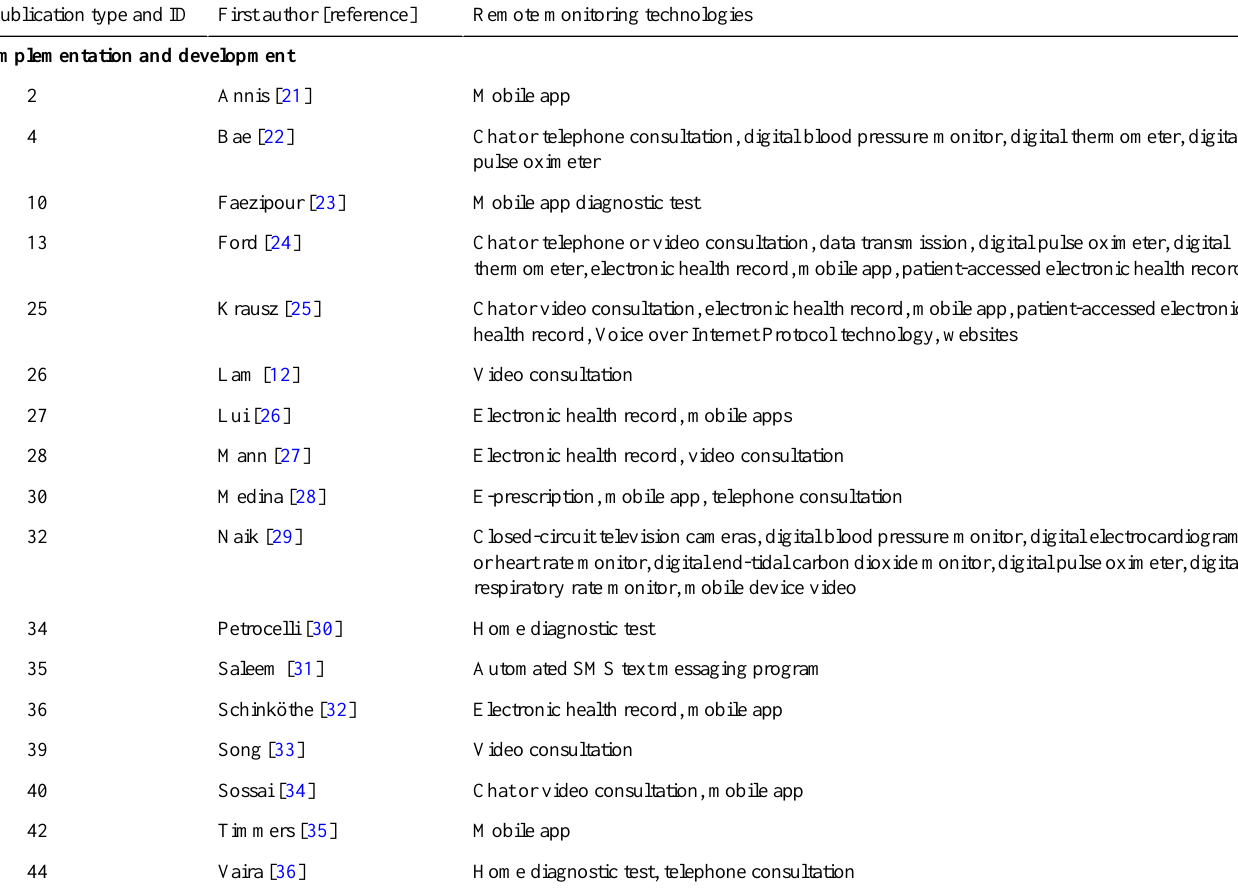
Remote monitoring technologiesFirst author [reference]Publication type and ID